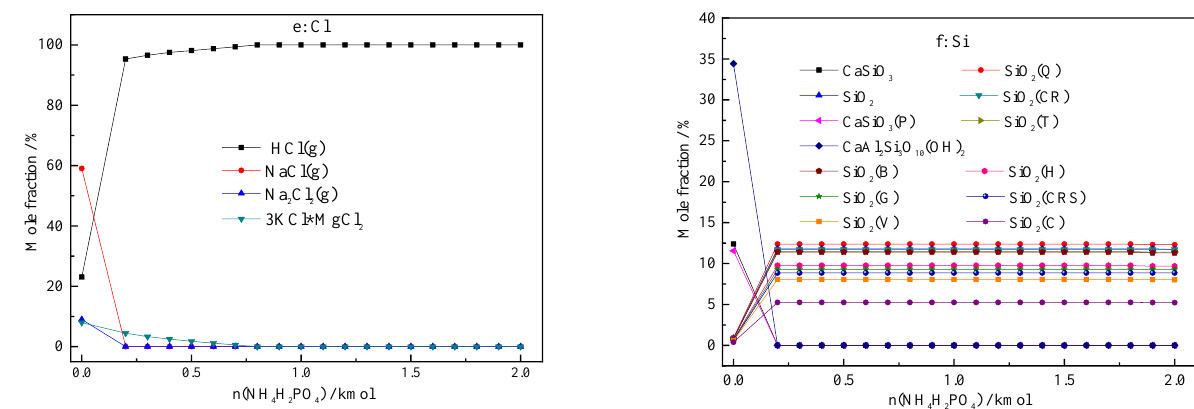
Figure 6. Effect of the amount of NH 4 HPO 4 addition on the migration and transformation of main elements in ash. ( a ): Na, ( b ): K, ( c ): Ca, ( d ): Mg, ( e ): Cl, ( f ): Si. The asterisk in the chemical formula shows that the molecules or species are attached with each other as independent species, similarly hereinafter.